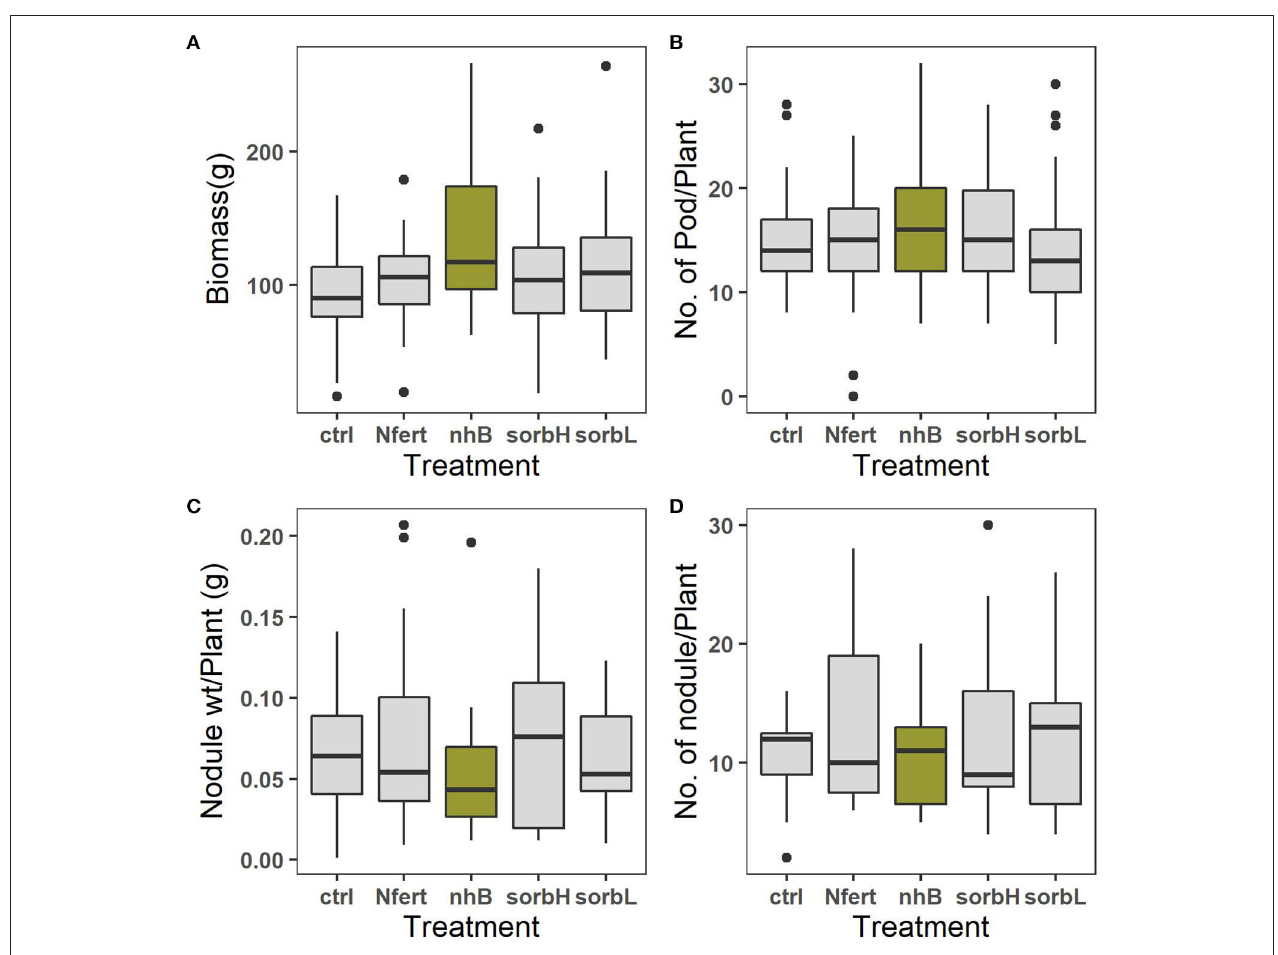
FIGURE 1 | Means of total biomass, grams per plant (A) , mean number of pods per plant (B) , mean weight of root nodule per plant (C) , and mean number of root nodules formed by roots per plant (D) in response to cowpea treatments; control, N fertilizer (Nfert), sorbitol (sorbL and sorbH), and non-hormonal biostimulant (nhB).